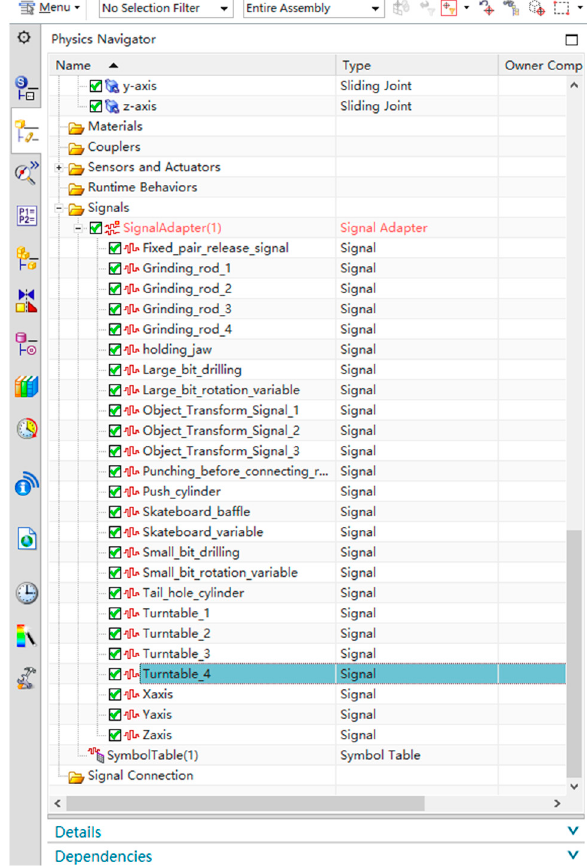
Figure 16. The setting details of the signal adapter.